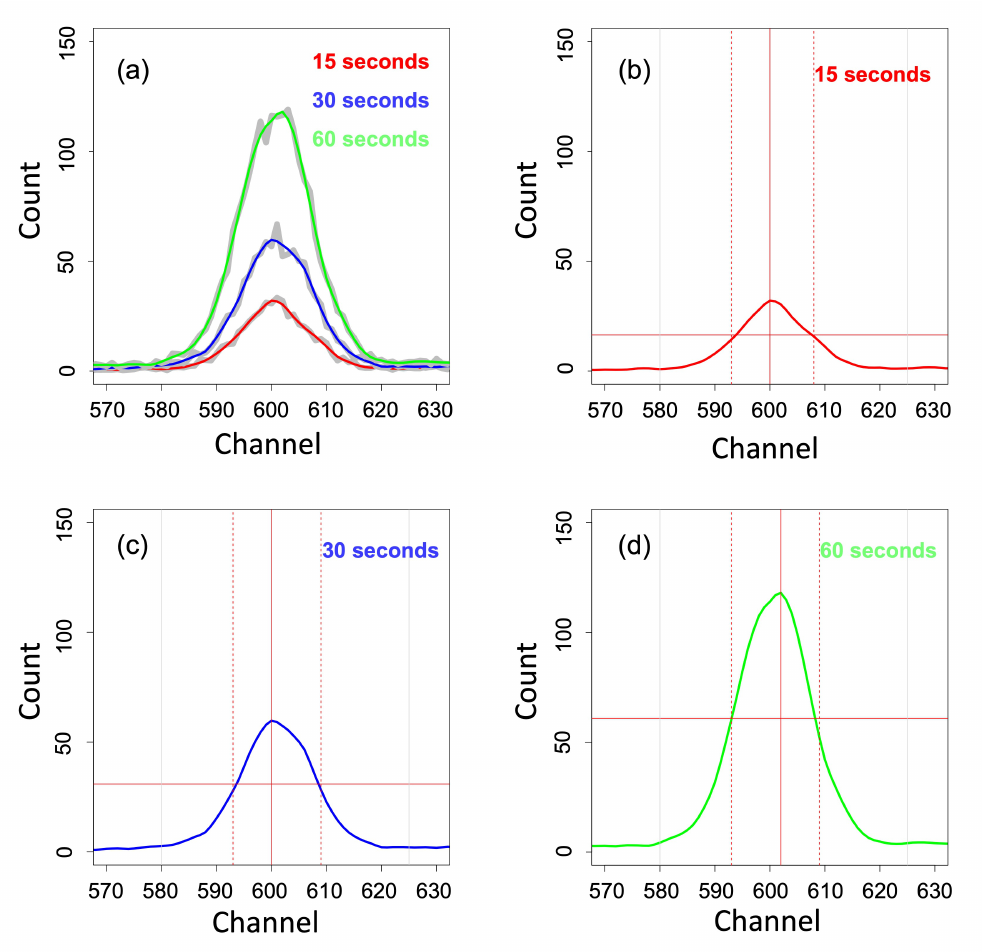
Figure 4. Processed XRF spectra and peak data extraction. ( a ) XRF spectra of Fe(K α 1 ) peak at 15, 30 and 60 s excitation times (grey lines) and smoothed spectra (coloured lines). ( b – d ) Plot from ‘peakshape’ function for Fe(K α 1 ) peak at 15, 30 and 60 s excitation times, respectively. The vertical continuous red line indicates the peak location, the horizontal continuous red line indicates the half-maximum count (or intensity), and the distance between the dashed lines is the full width at half height